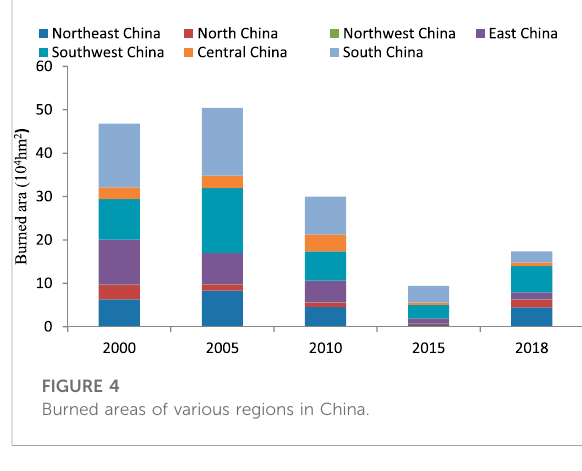
FIGURE 4 Burned areas of various regions in China.